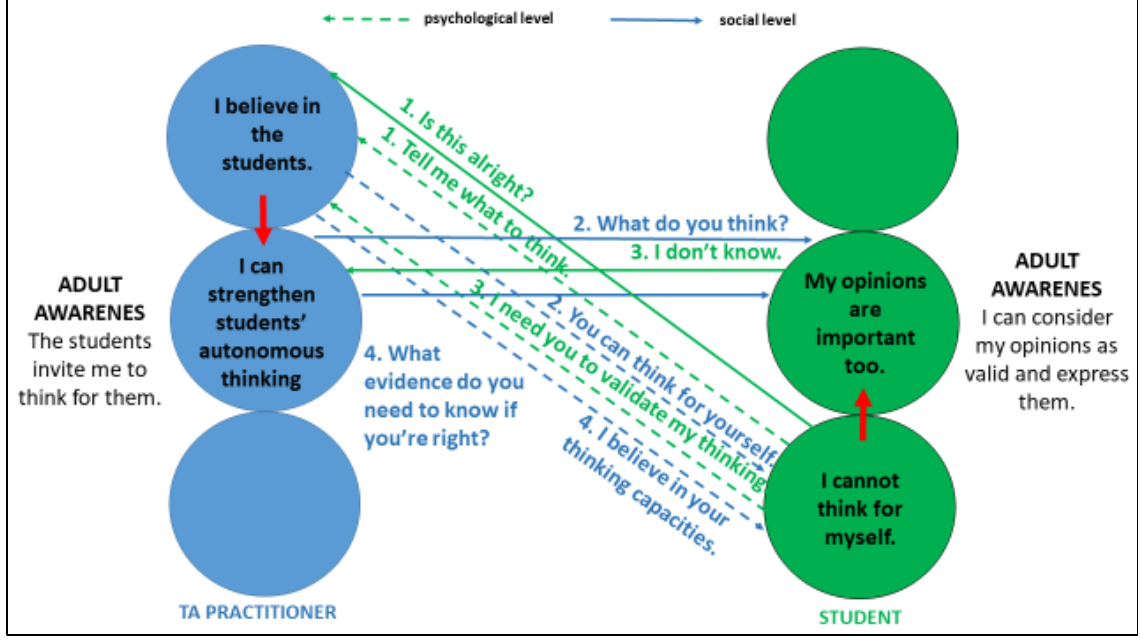
Figure 1: Crossing a Transaction to Confront Overadaptation